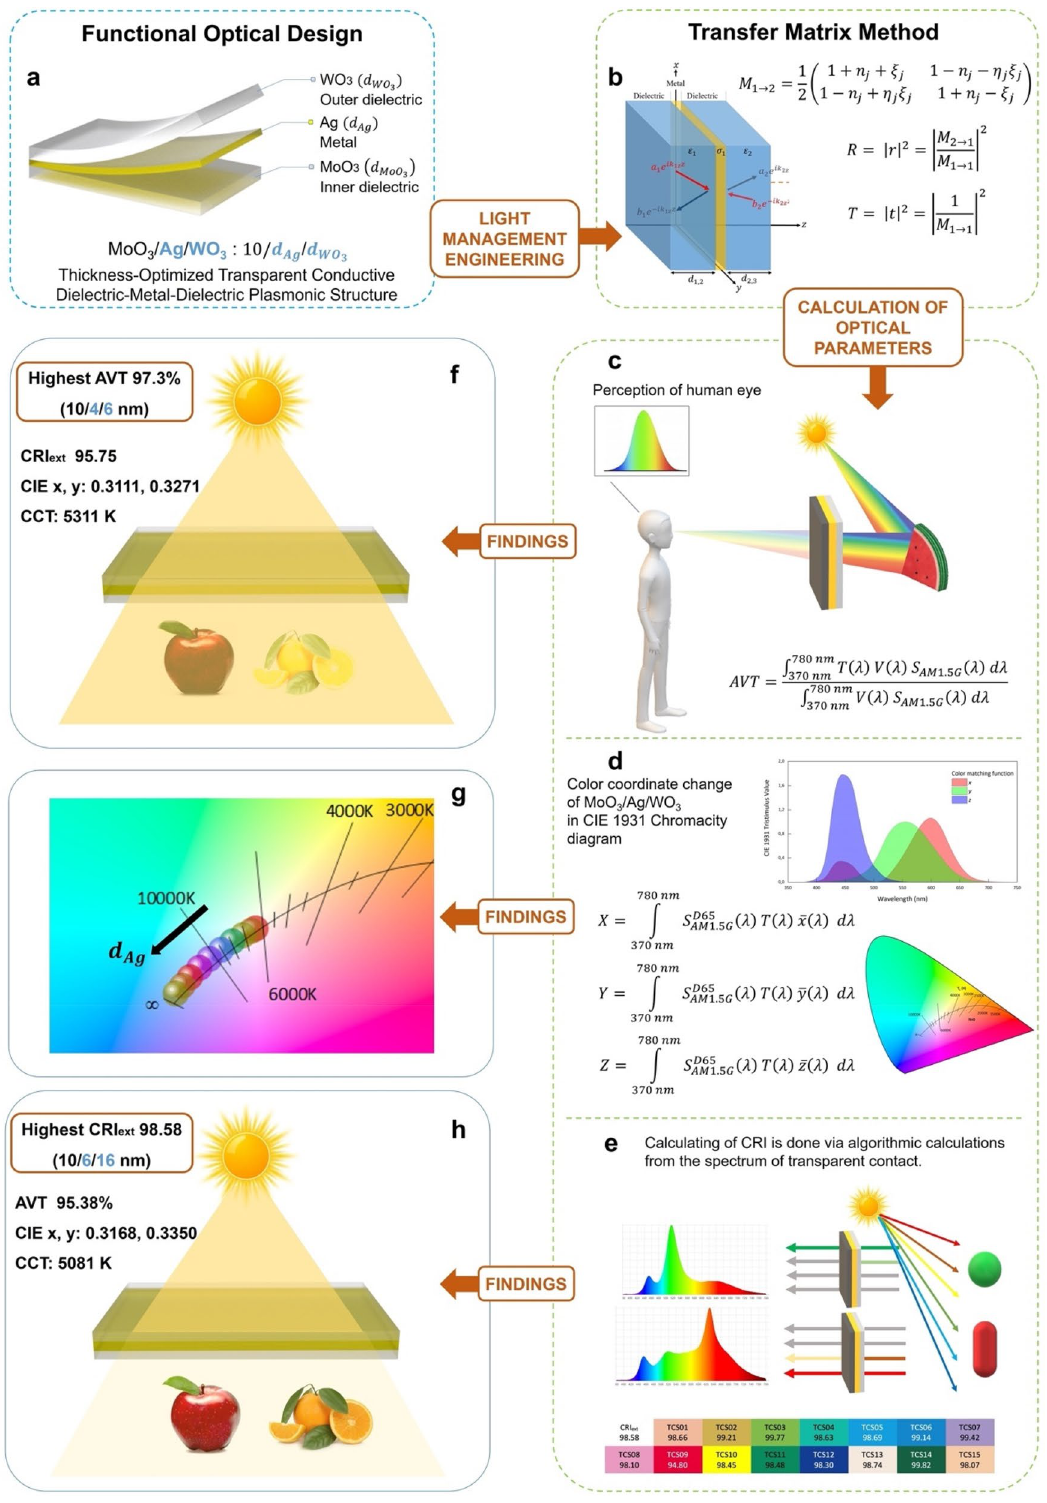
Figure 1. Functional optical design of transparent conductive plasmonic structure and its optical properties. ( a ) Schematic representation of MoO 3 /Ag/WoO 3 transparent conductive plasmonic structure. ( b ) Transfer Matrix Method used in the calculation of optical characteristics and its application in Dielectric/Metal/Dielectric plasmonic structures. Calculation of optical parameters: ( c ) Evaluation of average visible transmittance calculated based on human eye perception. ( d ) Determination of CIE 1931 color coordinates. ( e) Obtaining of color rendering index and test color samples. Findings in MoO 3 /Ag/WoO 3 transparent conductive plasmonic structure, which is optimally designed by evaluating on the basis of optical parameters: ( f) Highest Average Visible Transmittance. ( g ) Change of CIE 1931 color coordinates. ( h ) Highest color rendering